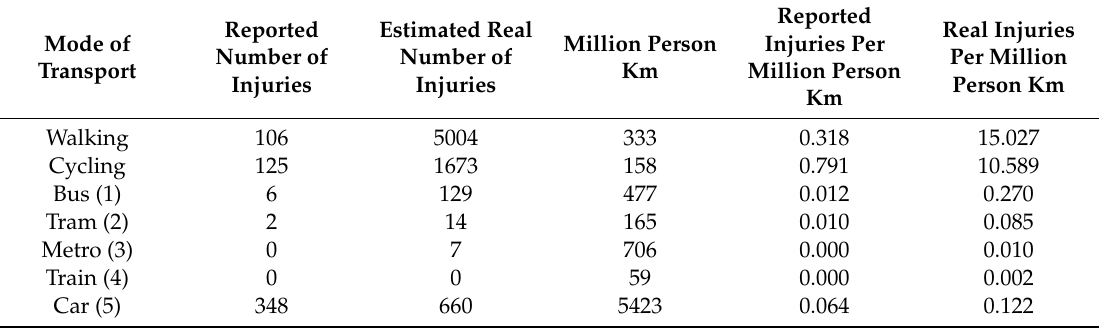
Table 3. Police reported and estimated true number of tra ffi c injuries in the city of Oslo,